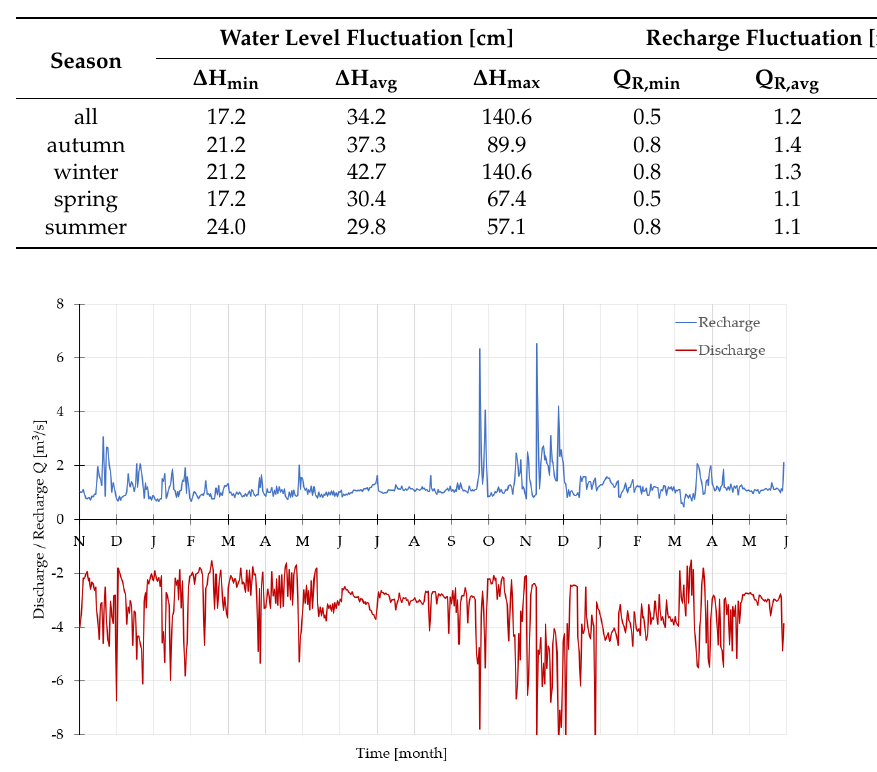
Figure 6. Time–series of daily recharge/discharge